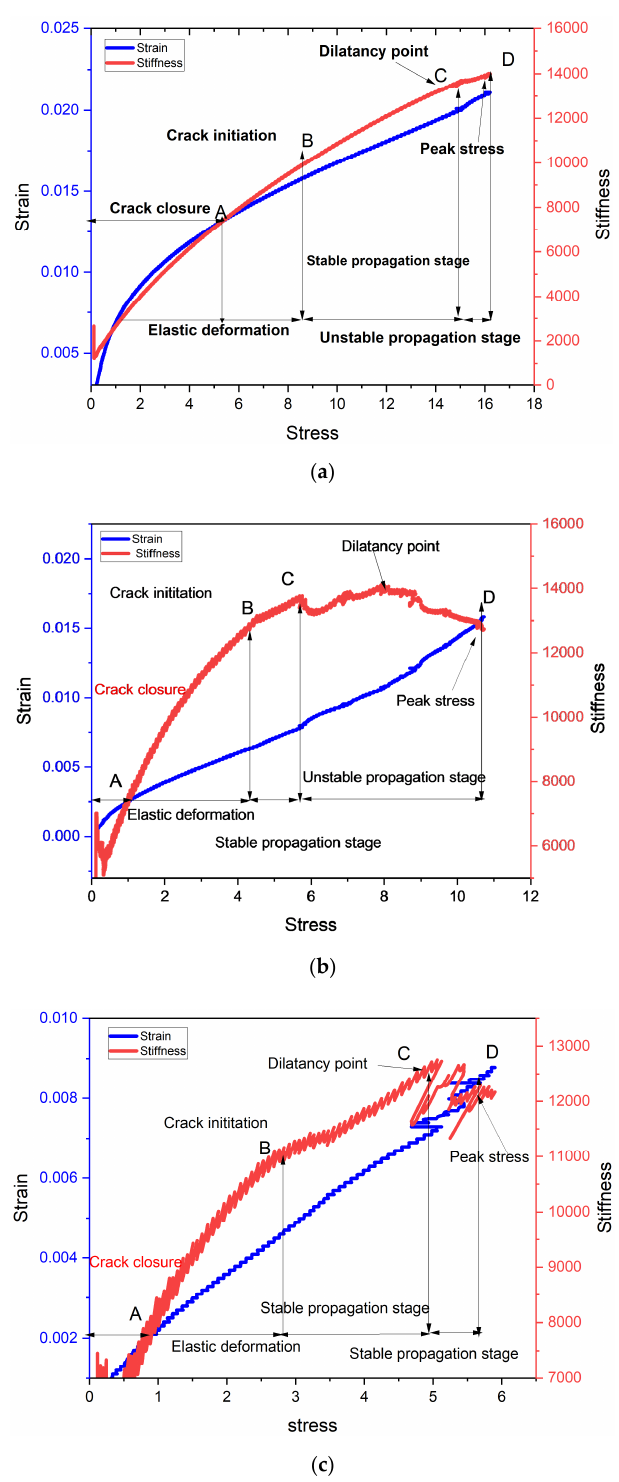
Figure 6. The Stress–strain and stress–stiffness curves of ( a ) dry, ( b ) natural, and ( c ) saturated coal